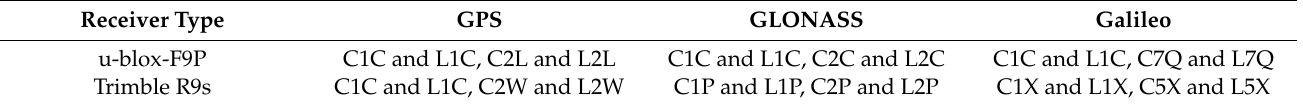
Table 1. GPS, GLONASS, and Galileo pseudorange and carrier phase